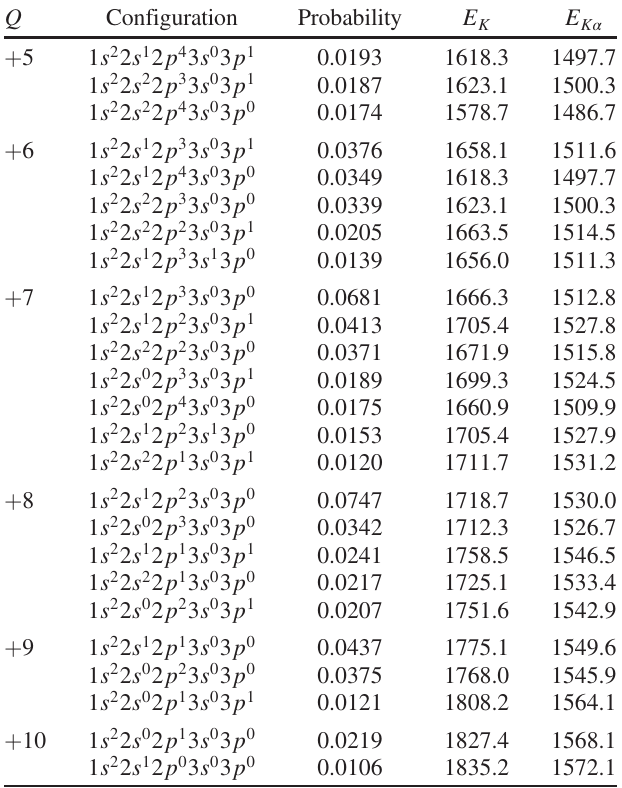
TABLE II. Probability distribution of bound-electron configu- rations at T ¼ 80 eV. Configurations are listed when their probability is greater than 0.01, and the probability is calculated from the first step. K -shell ionization energy ( E K ) and K α transition energy ( E K α ) are calculated from the second step of our two-step HFS model. E K and E K α are in eV.